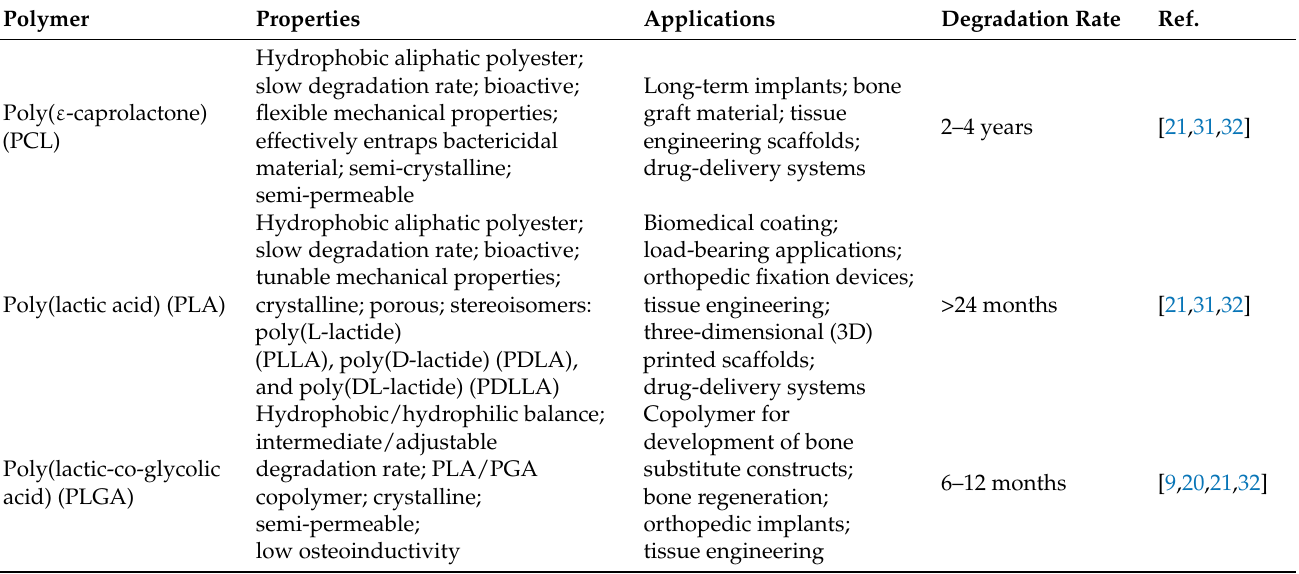
Table 1. Overview of the characteristics of synthetic polymers. Polymer Properties